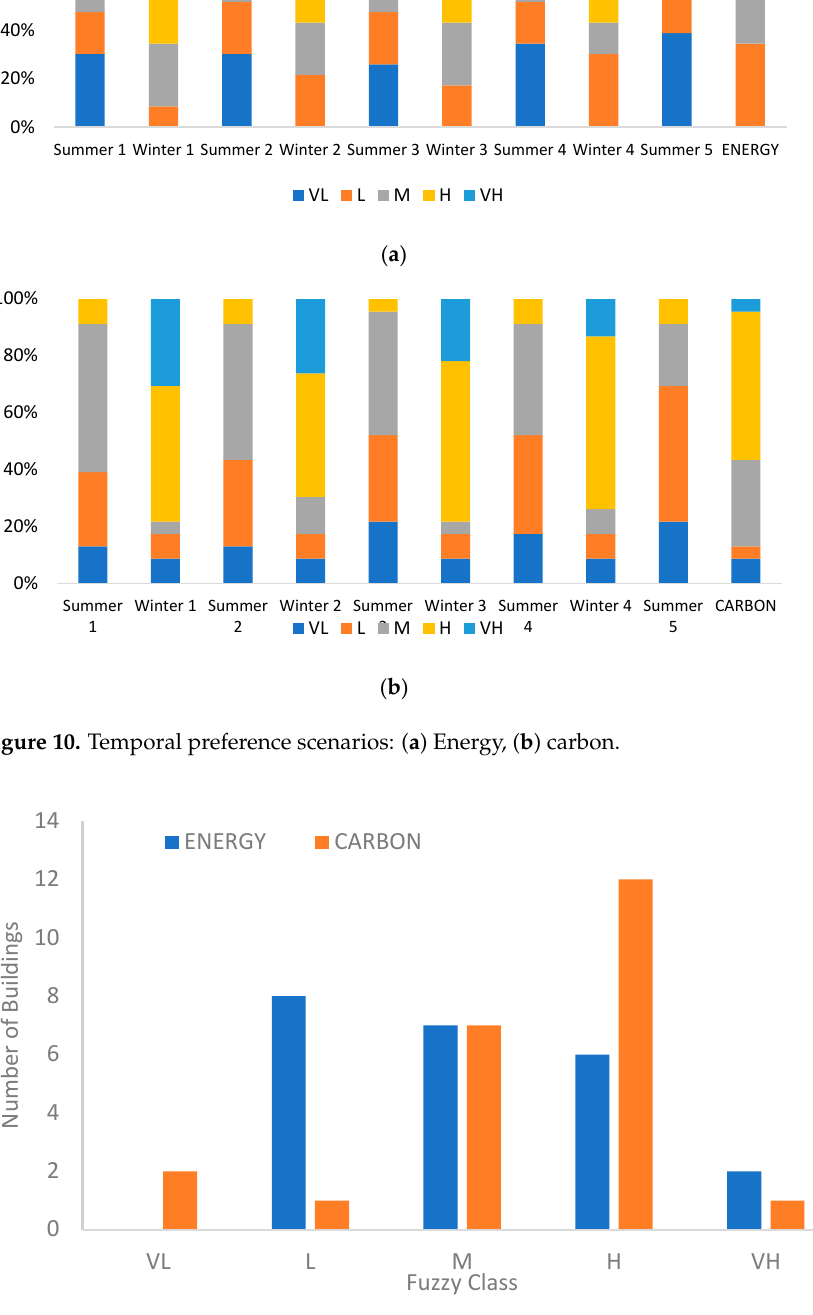
Figure 11. Energy and carbon preference scenarios classification per building.